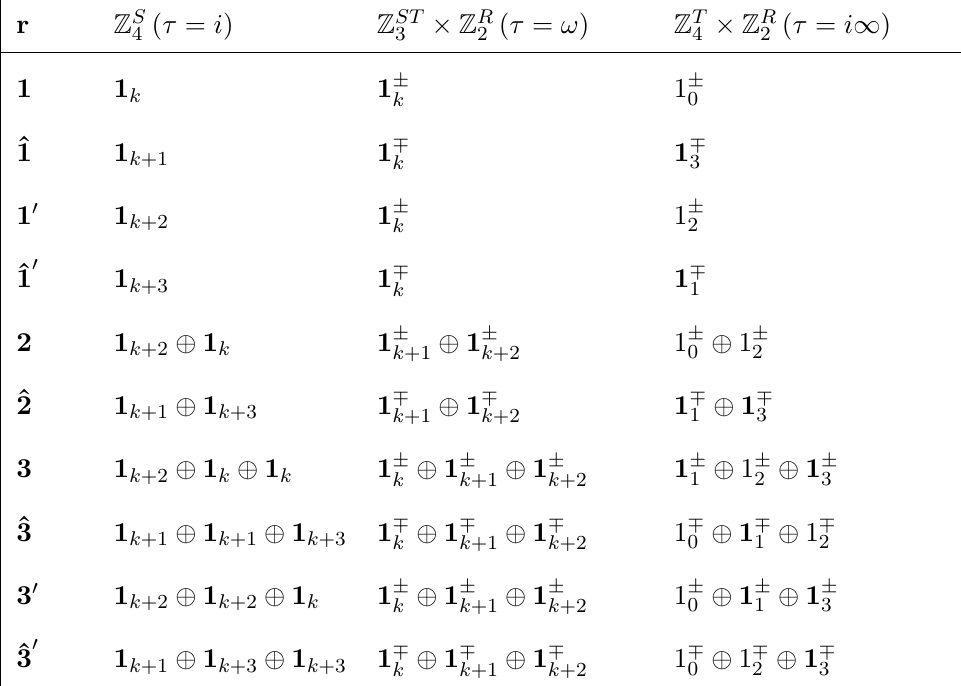
Table 8. Decompositions of ‘weighted’ ( r , k ) multiplets of Γ 0 symmetry groups. Irrep subscripts should be understood modulo n , where n = 4 , 3 in the first and second columns, respectively. Upper (lower) signs correspond to even (odd) values of k